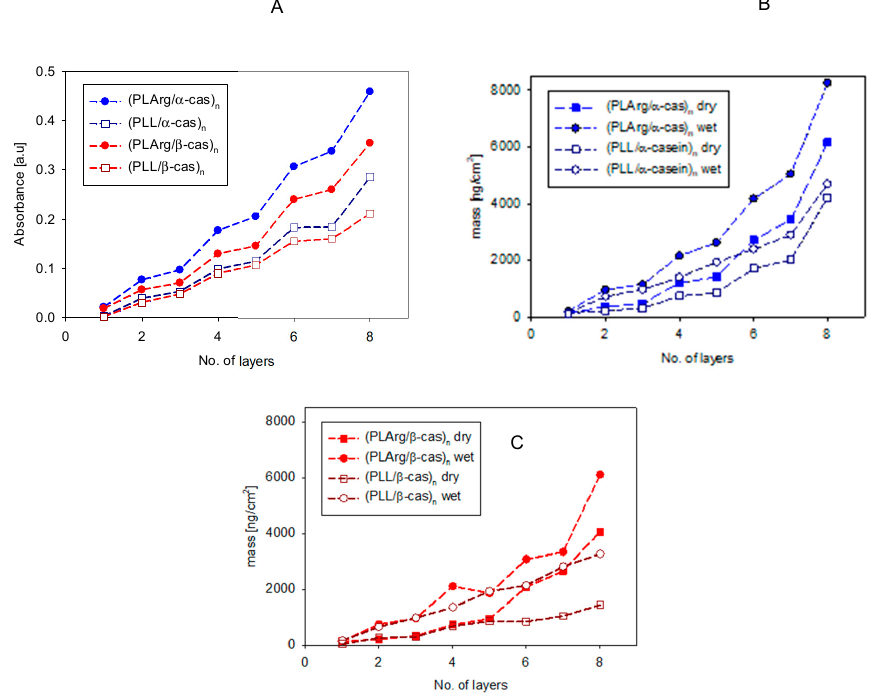
Figure 6. The dependence of the maxima of absorbance value of amide I band vibration of PLArg or PLL and α - or β -casein ( A ), and dry and wet mass of (PLArg/cas) n and (PLL/cas) n films ( B , C ) on the number of adsorbed layers (QCM_D and ellipsometry measurements).